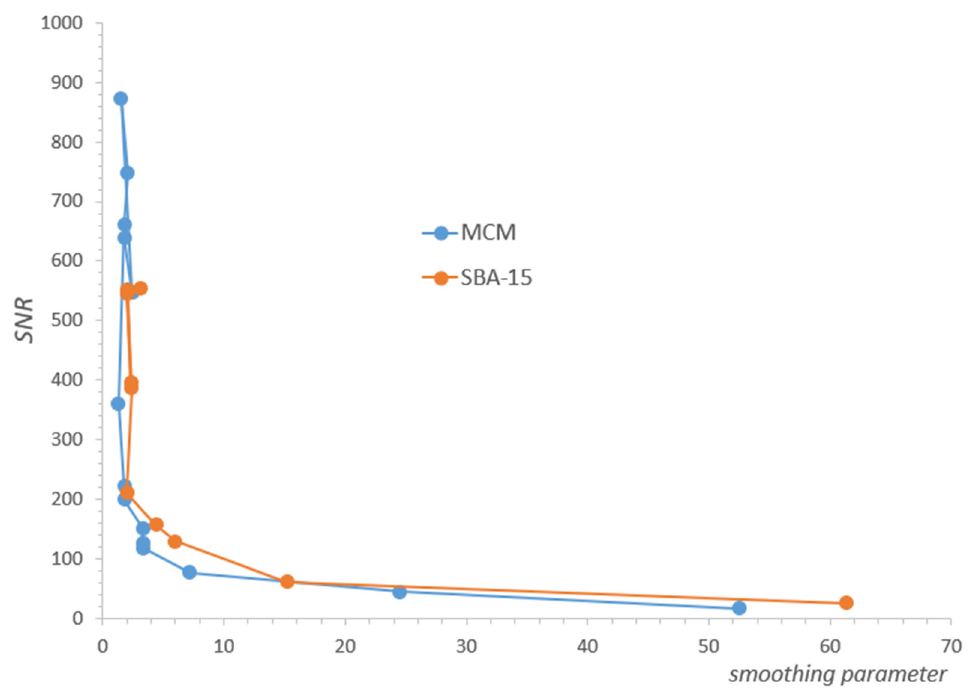
Figure A1. The regularization parameter for ILT transform increases as SNR (Signal-To-Noise-Ratio)